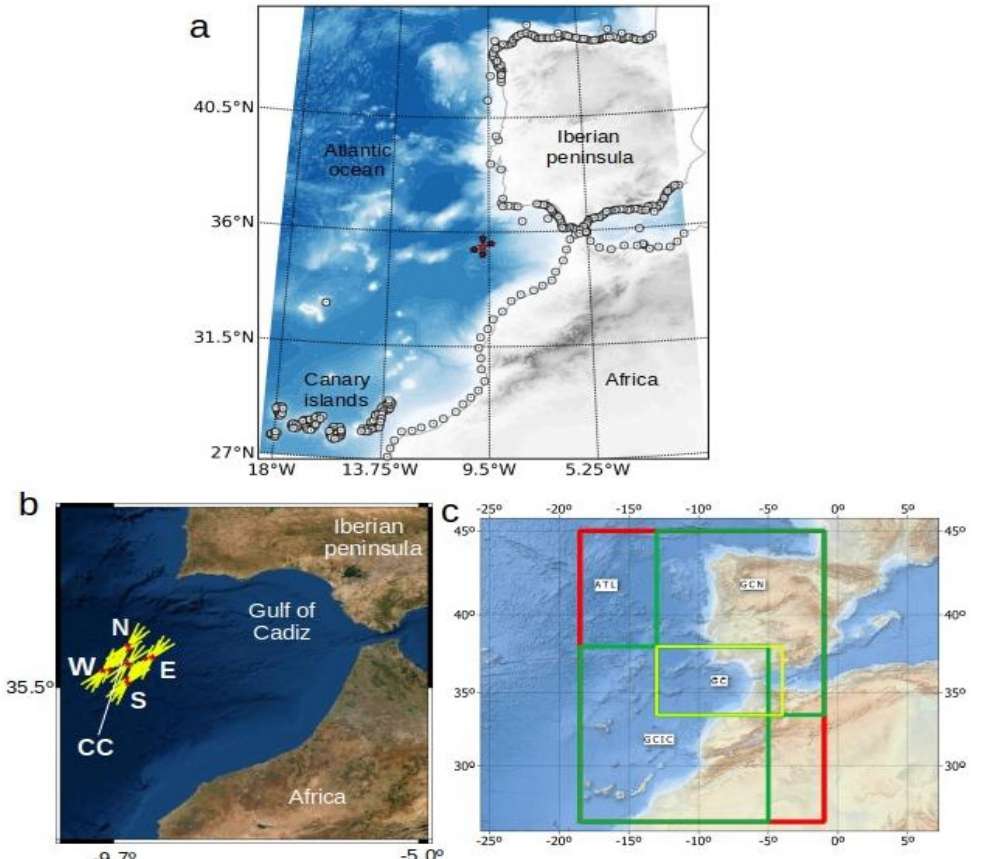
Figure 3. ( a ) Atlantic computational domain (ATL) at 1/2 arcmin resolution, scenario epicenter locations (red stars), and FCPs (circles); ( b ) epicenter locations (CC, N, E, S, W) and strikes of the computed scenarios; and ( c ) the four rectangular domains with different resolutions used in this study: Atlantic (ATL), Gulf of Cadiz and Canary Islands (GCIC), Gulf of Cadiz and north of the Iberian peninsula (GCN), and Gulf of Cadiz (GC). Domain boundary coordinates are given in Table 2.